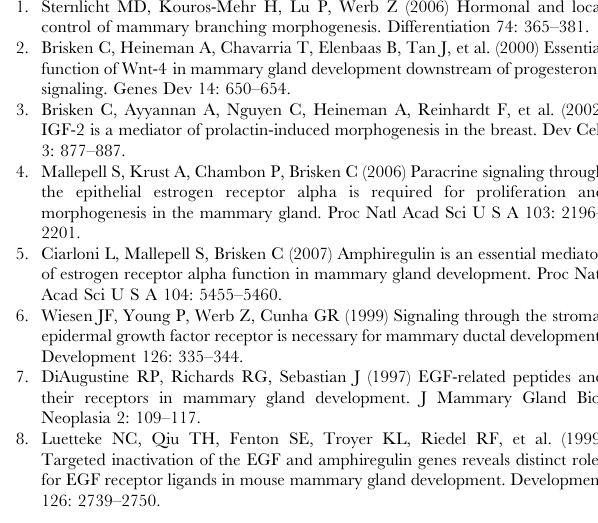
Figure S4 A. ERK1/2 and AKT phosphorylation in starved NMuMG cells and ErbB2 tumor cells treated with Iressa and the indicated cytokines. B. % confluence calculated from the experiment shown in Video S3. C. 2D-growth (upper fields) and 3D-morphogenesis (lower fields) of NMuMG cells treated with the indicated factors (10 ng/ml).